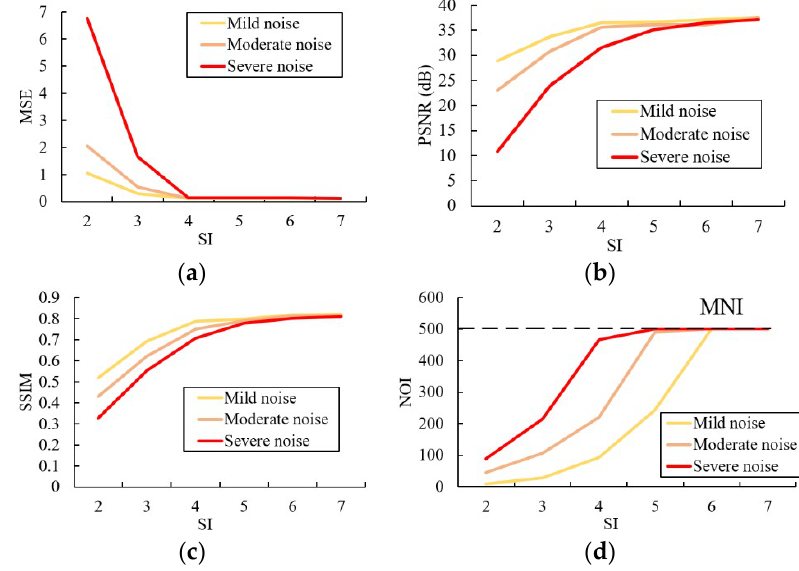
Figure 3. Test results of ( a ) mean square error (MSE); ( b ) peak signal-to-noise ratio (PSNR); ( c ) structure similarity (SSIM); ( d ) number of iterations (NOI) at different settings of stopping index (SI)) for three levels of noise.